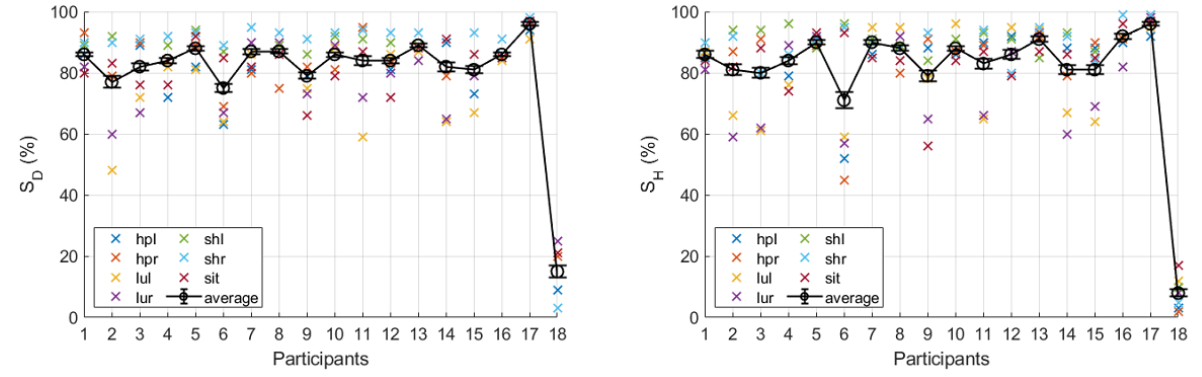
Figure 11. The combined and averaged scores (left: SD and right: SH) for all seven exercises. Error bars indicate the standard